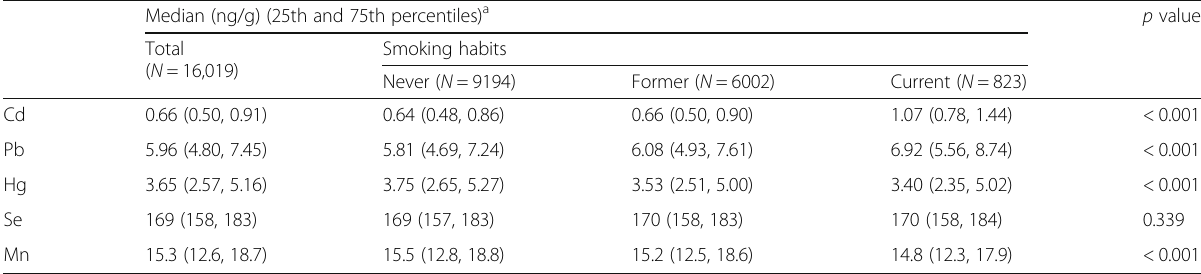
subjects with Q4 Cd than those with Q1 Cd (OR, 2.06; 95% confidence interval [CI], 1.07, 3.98; p = 0.031). Further, the OR for placenta previa was significantly higher among sub- jects with Q2 Pb than those with Q1 Pb (OR, 2.59; 95% CI, 1.40, 4.80; p = 0.003). There was a significant relationship be- tween placenta previa and Pb concentrations (P for trend = 0.007). There was no significant relationship between pla- centa accreta and metal concentrations (Table 3). Table 2 The distribution of metal concentrations by smoking habits Median (ng/g) (25th and 75th percentiles) a p value* Total ( N =